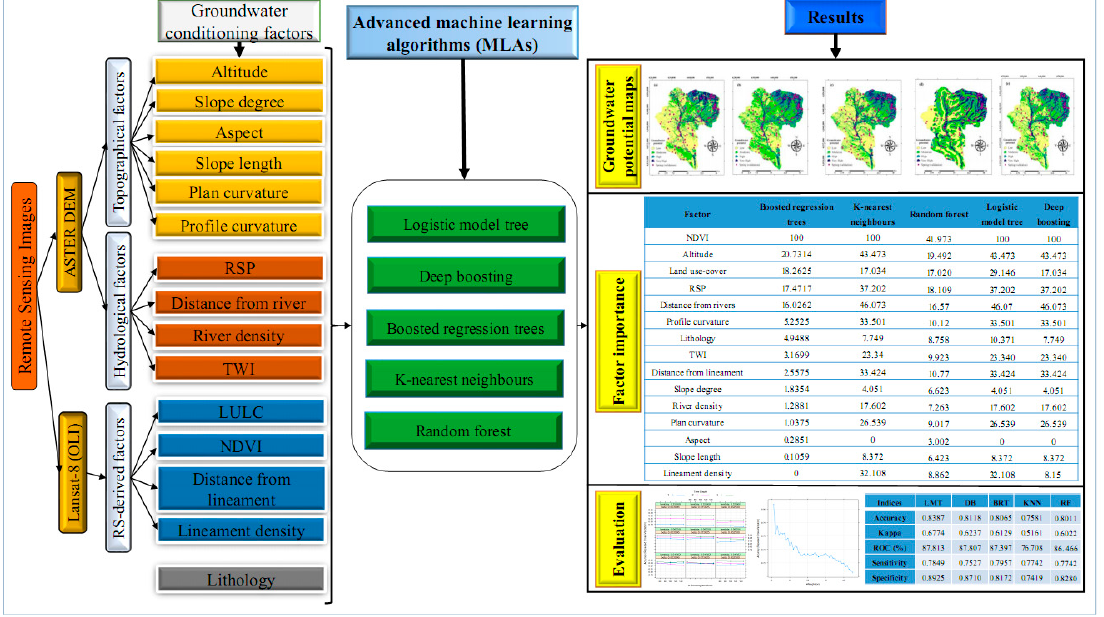
Figure 1. Flowchart of the methodology applied in this research.